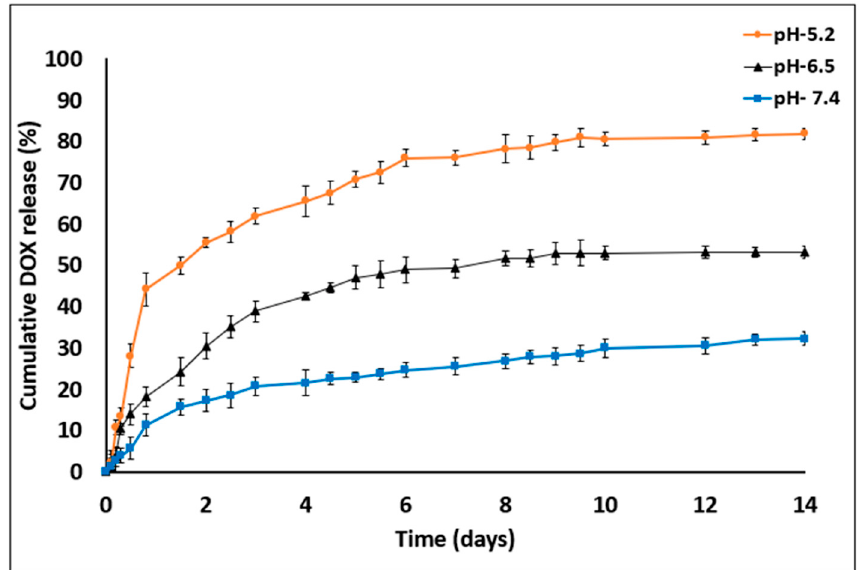
Figure 7. DOX release profile studies in PBS with three different pH value—7.4, 6.5 and 5.2 for 14 days. DOX cumulative release increased in acidic medium conditions (empty particles were used as control. n = 3; mean ±